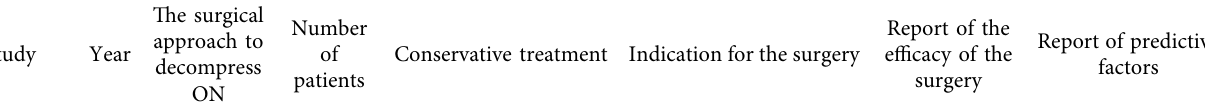
Table 2: Summary of the case series evaluating the efficacy of the procedure, surgical indications, and predictive pretreatment factors.